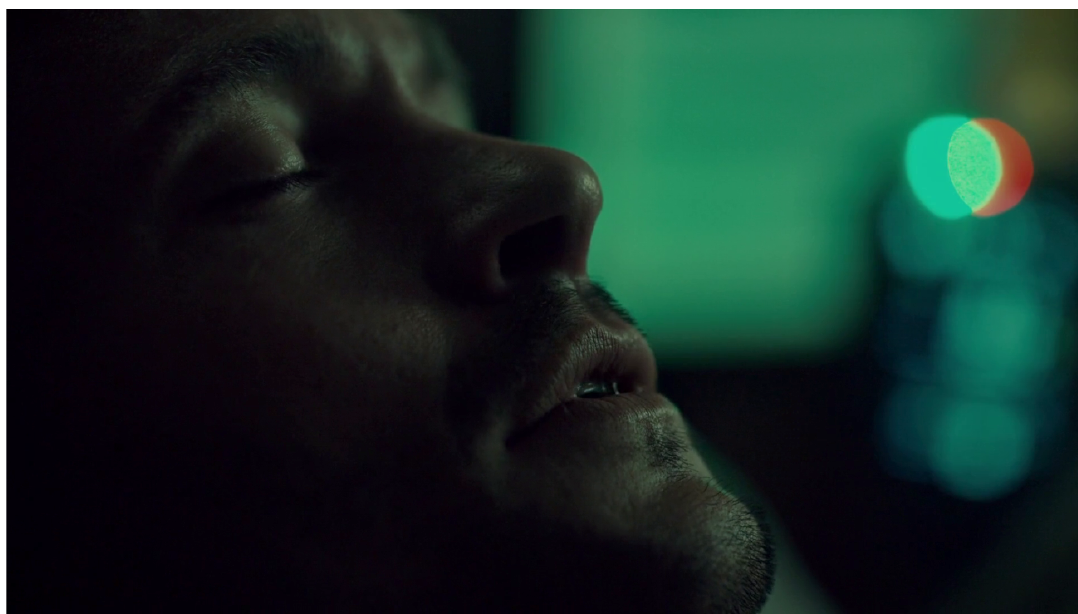
Figure 7. The motif of Jungian Mysterium Coniunctionis returns in Season 3, ep. 2, “Primavera,” directed by Vincenzo Natali.